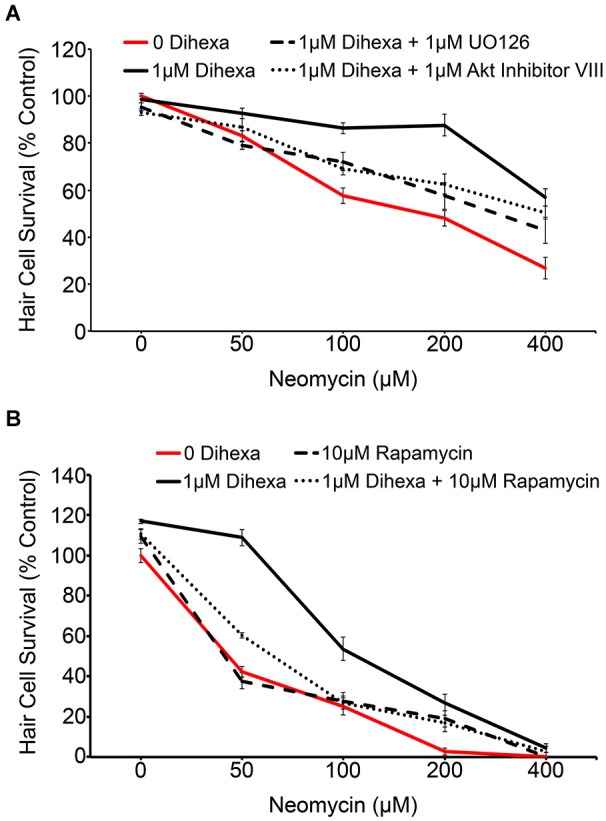
Dihexa-mediated protection is inhibited by MEK, Akt, and TOR inhibitors. (A) Co-treatment with 1 μM MEK or Akt inhibitors (UO126 and Akt Inhibitor VIII, respectively) partially attenuates Dihexa-dependent protection (Two-way ANOVA; Dihexa: F(3,144) = 37.13 p < 0.001). When comparing the 1 μM Dihexa treatment vs. 1 μM Dihexa plus 1 μM UO126 p-values are as follows: 50 μM neomycin (p < 0.05), 100 μM neomycin (p < 0.05), 200 μM neomycin (p < 0.001), and 400 μM neomycin (p < 0.05). When comparing the 1 μM Dihexa treatment vs. 1 μM Dihexa plus 1 μM Akt inhibitor VIII p-values are as follows: 50 μM neomycin (p > 0.05), 100 μM neomycin (p < 0.05), 200 μM neomycin (p < 0.001), 400 μM neomycin (p > 0.05). (B) Co-treatment with 10 μM of the TOR inhibitor, rapamycin, also partially attenuates Dihexa-mediated protection from neomycin (Two-way ANOVA; Dihexa: F(3,120) = 70.41 p < 0.001). When comparing the 1 μM Dihexa treatment vs. 1 μM Dihexa plus 10 μM rapamycin p-values were as follows: 50 μM neomycin (p < 0.001), 100 μM neomycin (p < 0.001), 200 and 400 μM neomycin (p > 0.05). N = 6–9 animals per treatment, error bars represent ± s.e.m.